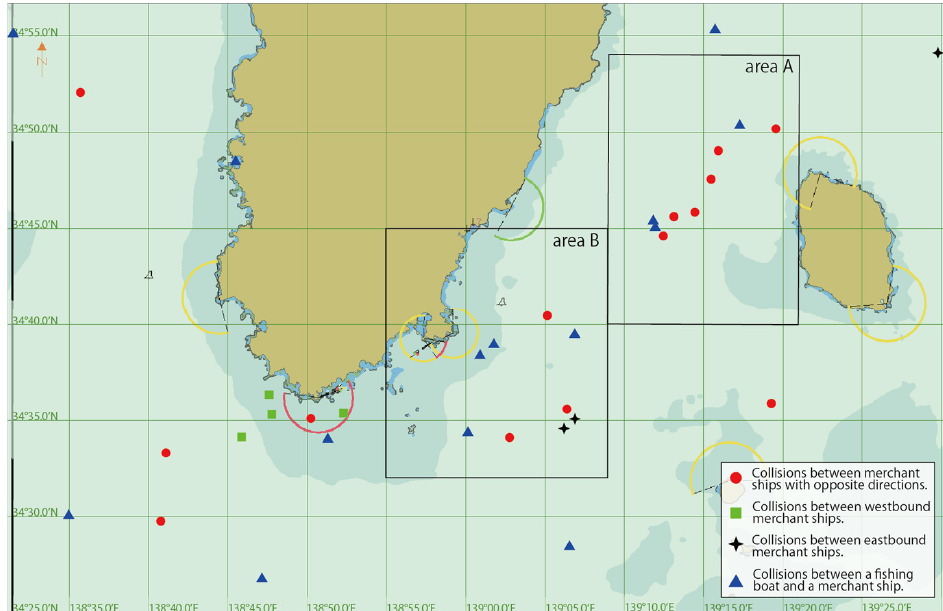
Figure 5. Collision locations by encounter type from 2005–2014. (Source: collision accident data in [8]) Note: the description of area A and B are in Section 5.3.